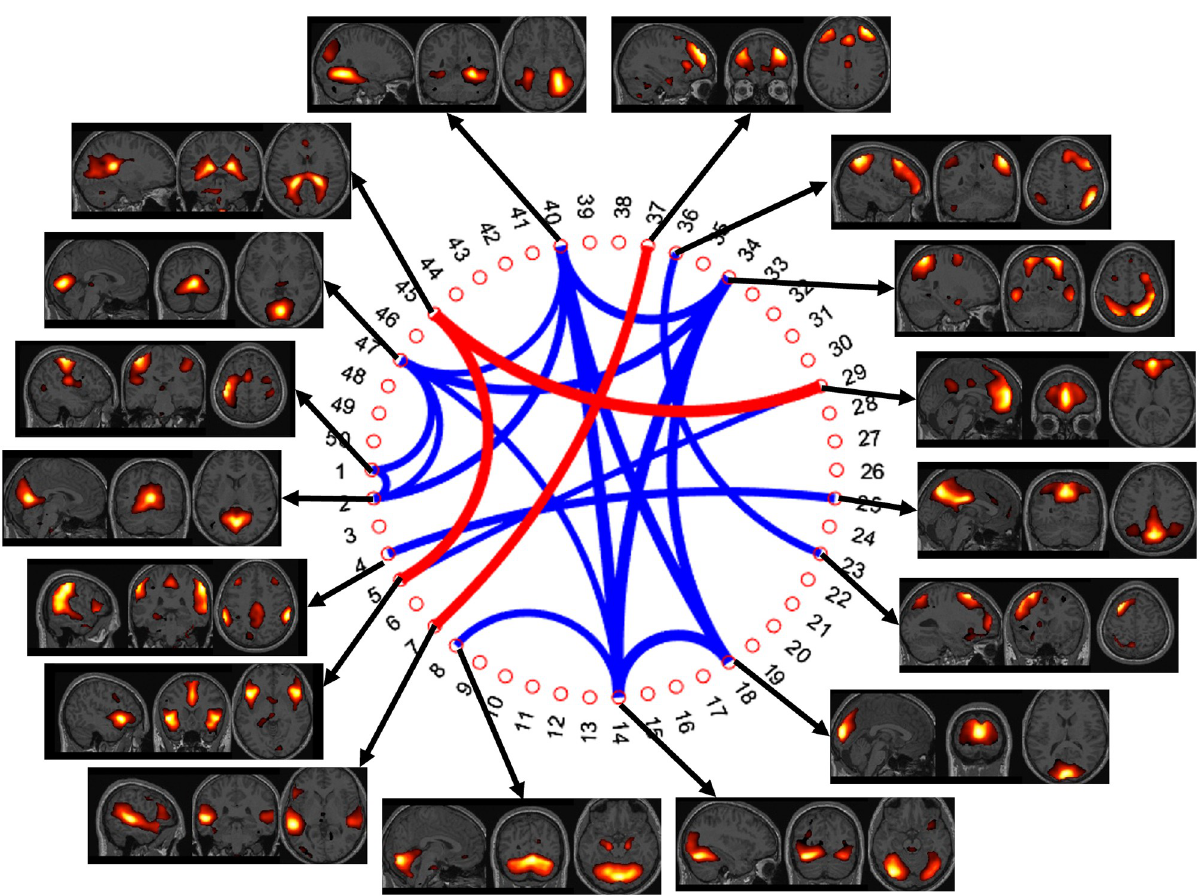
Fig 4. Functional connectivity analysis result for first 10 seconds (beginning) of the app stimulus. The number on the outer ring corresponds to IC numbers while the thickness of the line connecting pair of number shows the strength of correlation between the time series of the regions (blue = positive, red = negative). Thicker lines indicate correlation was observed for a greater number of subjects. The plot shown is thresholded at 8 subjects so the thinnest line is consistent correlation for 8 subjects and the thickest line is for consistent correlation in all 14 subjects.